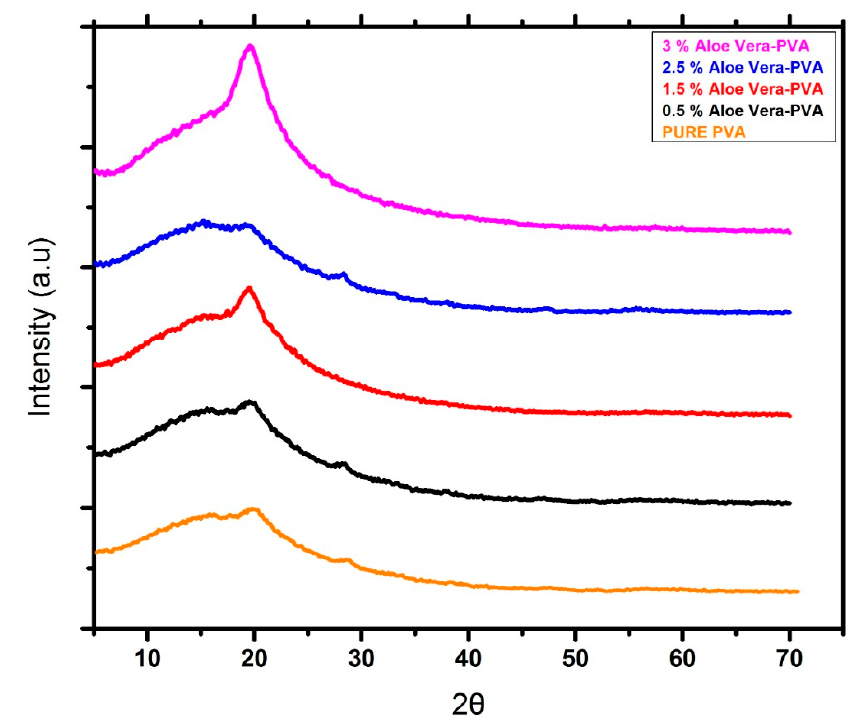
Figure 6. XRD spectra of pure PVA, 0.5%, 1.5%, 2.5%, and 3% AV/PVA electrospun nanofibers. .